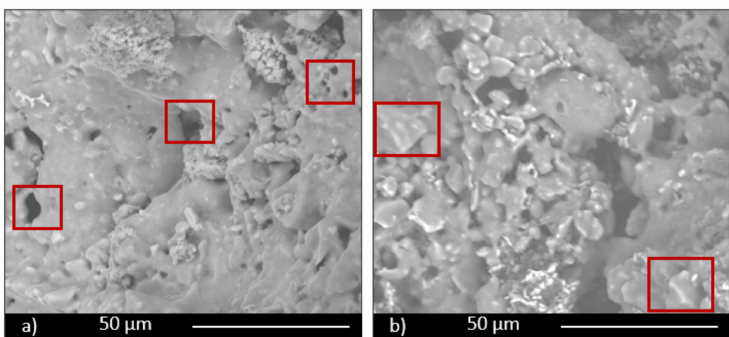
Figure 6. Magnification of images of scaffold (SS FG30) surface ( a ) and section ( b ).